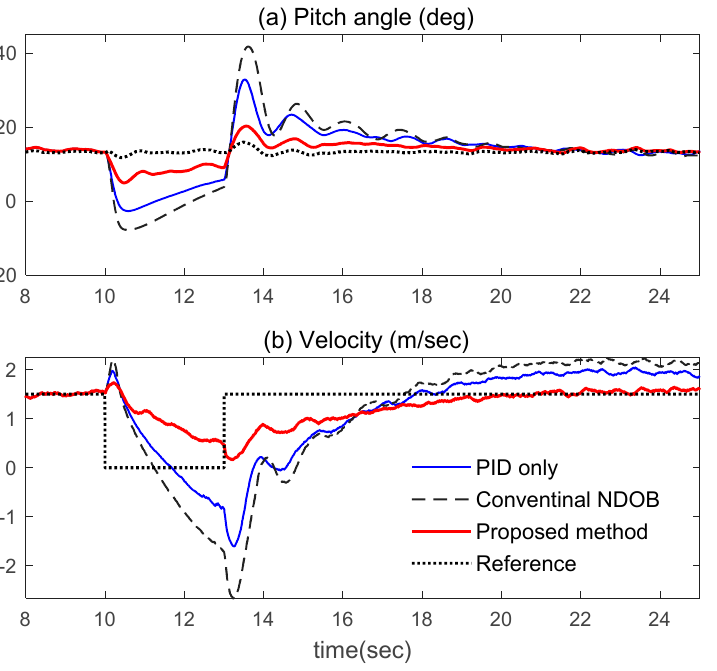
Figure 9. Holding a standstill position on a ramp with an unknown slope of 10 degrees.